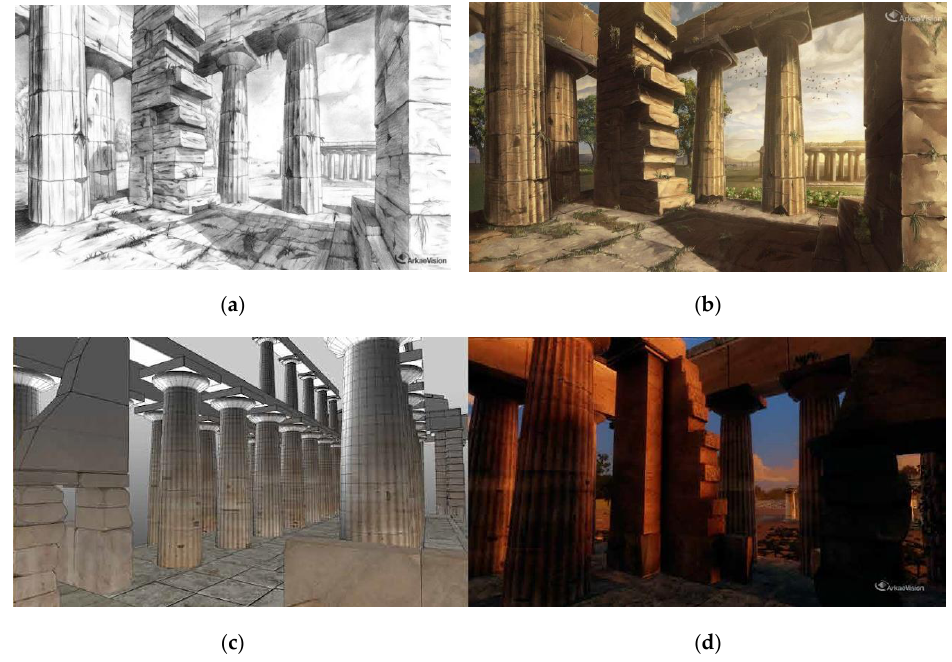
Figure 10. Shots aimed to study how to reproduce the atmosphere of the past: ( a ) first a black and white drawing, ( b ) a colored version, then ( c ) a digital canvas till arriving at ( d ) the 3D model. Copyright © Digitalcomoedia.